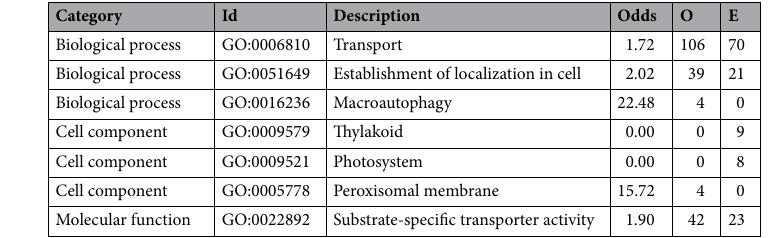
Table 5. Selected Gene Ontology enrichment analyses results. “O” and “E” are Observed and Expected number of genes in the “ ASm0SRm60 ” set,